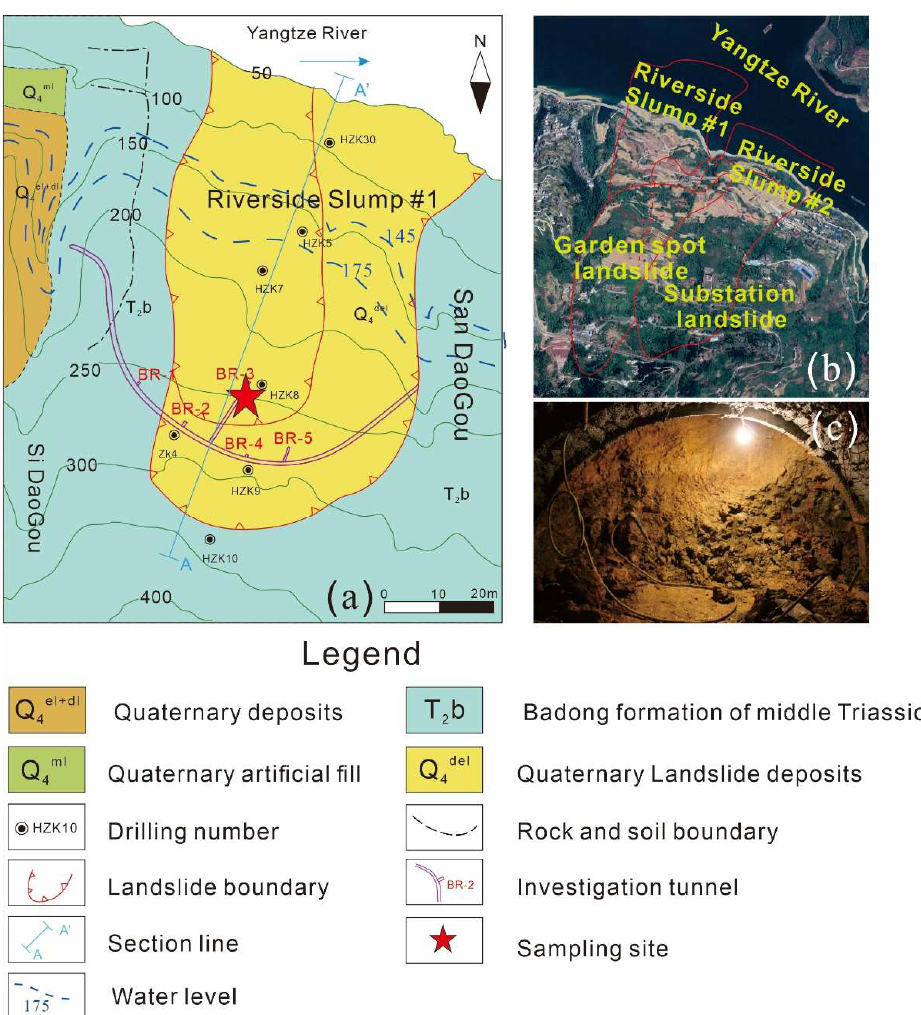
Figure 3. ( a ) The plan view of the Riverside Slump #1. ( b ) Composition of Huangtupo landslide. ( c ) Sampling site.